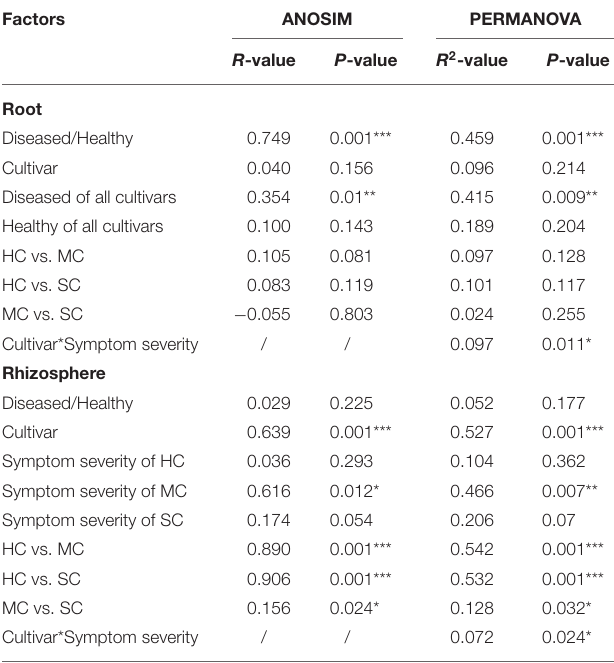
TABLE 1 | Pairwise comparisons of fungal communities based on ANOSIM and PERMANOVA of Bray-Curtis distance for the different factors. Factors